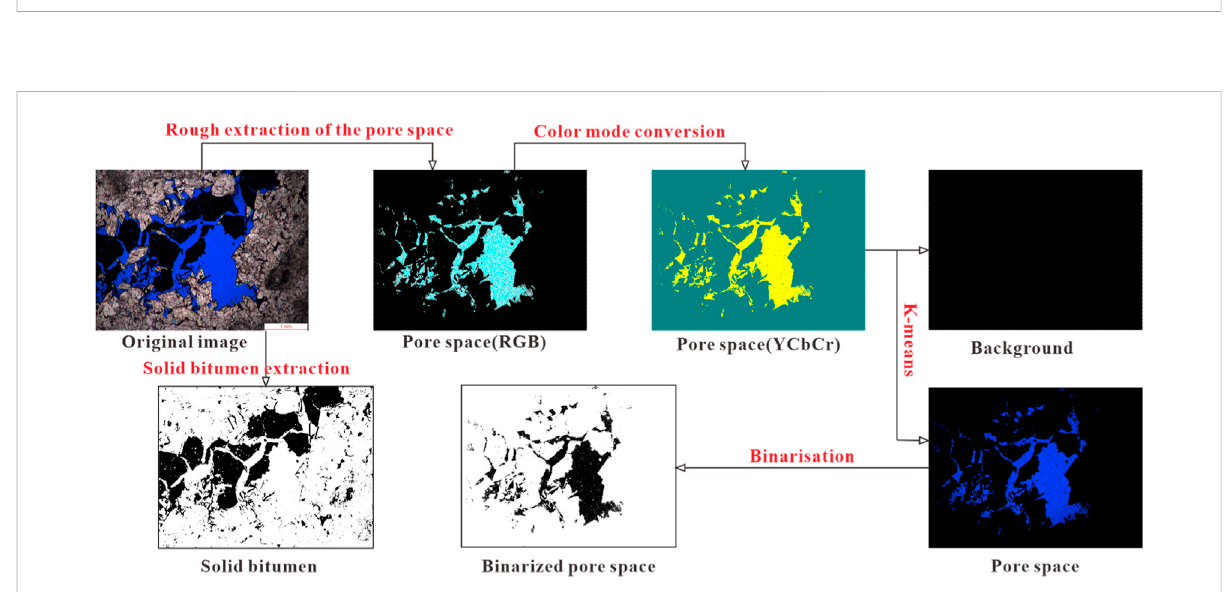
Frontiers in Earth